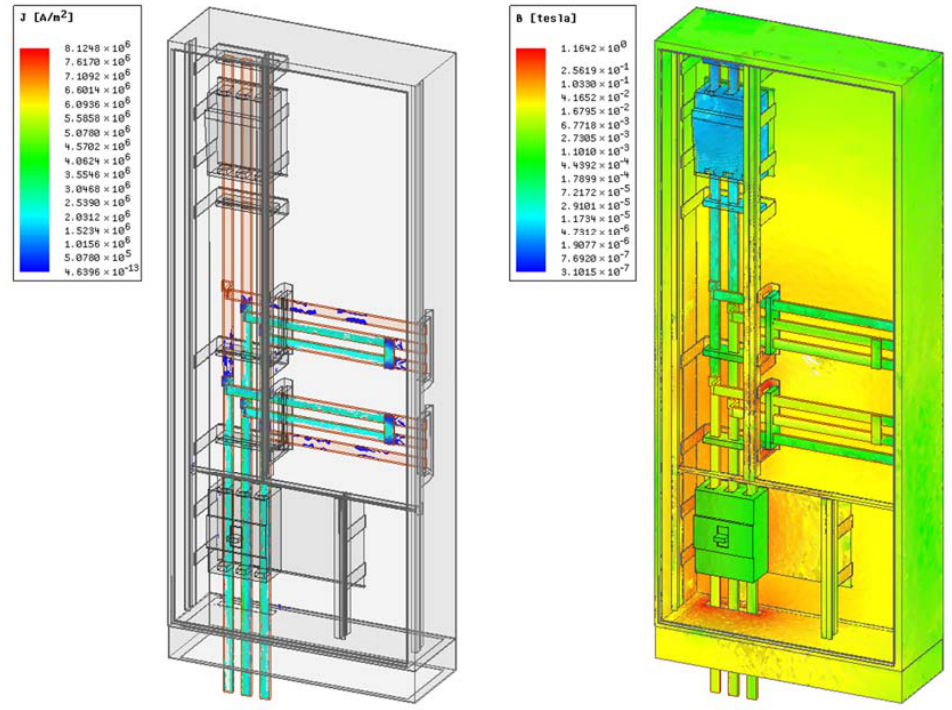
Figure 7. Current density distribution in busbars (on the left), electromagnetic induction field distribution in the switch- gear (on the right). distribution in the switchgear (on the right)